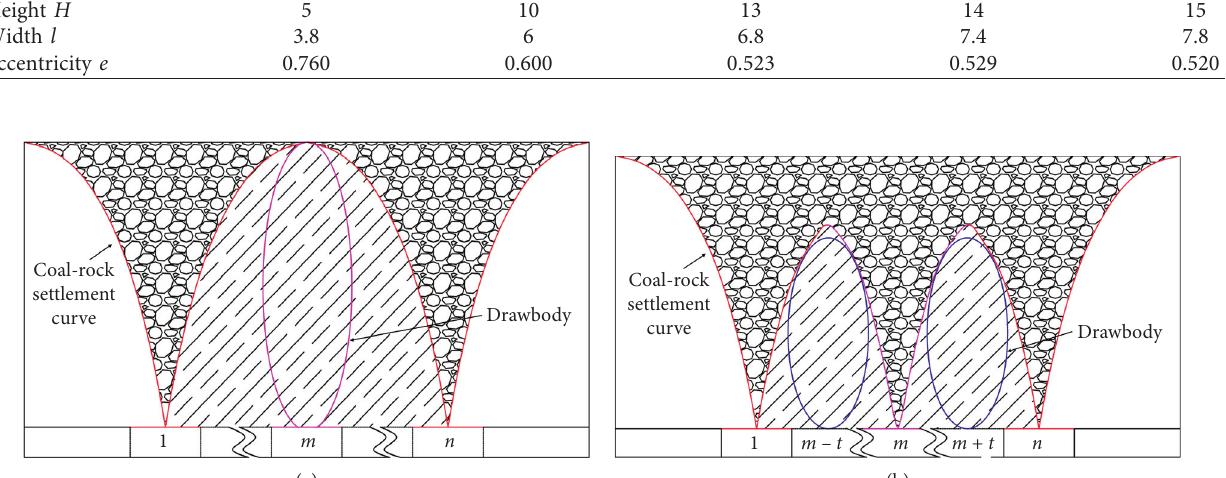
Figure 4: Illustration of the sectional interval symmetrical coal caving